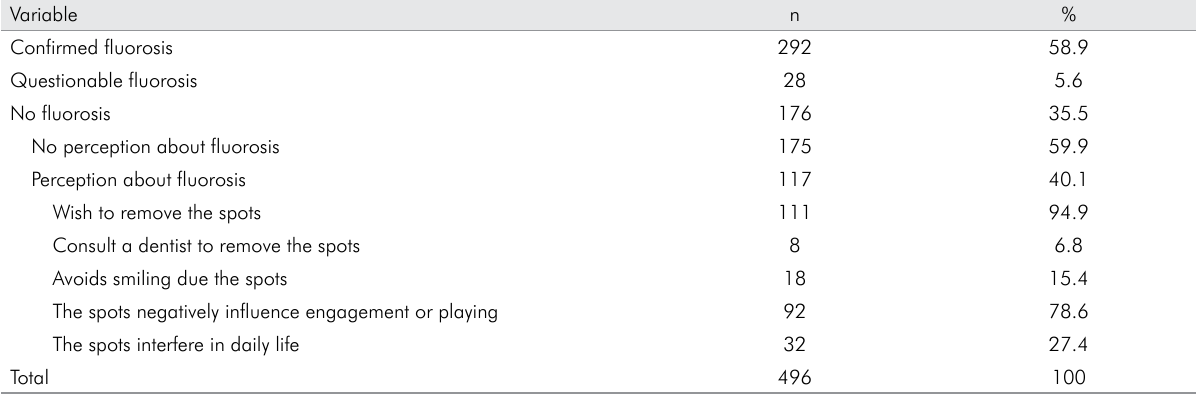
Table 2. Distribution of examined children according to the prevalence of fluorosis prevalence, self-perception, and their feelings and attitudes about the clinical symptoms. Birigui, SP, Brazil, 2014.